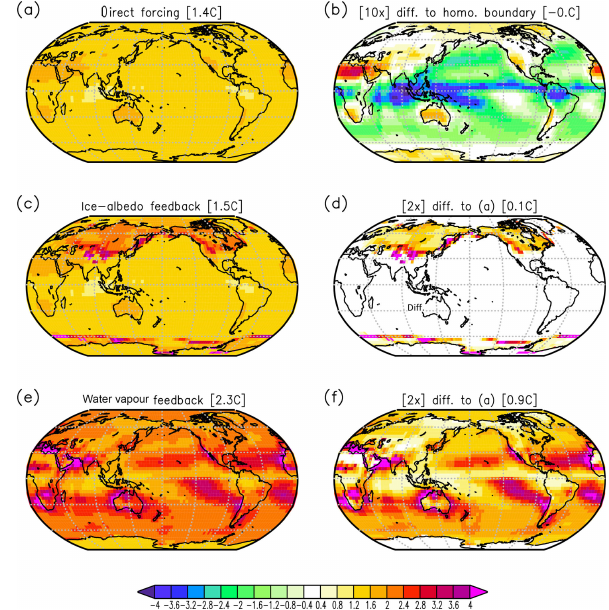
Figure 10. Local T surf response to doubling of the CO 2 concentra- tion in experiments without atmospheric transport (each point on the maps is independent of the others). (a) GREB with topography, humidity, cloud processes, and all other processes OFF. (b) Differ- ence of (a) to GREB with topography and all other processes OFF scaled by a factor of 10. (c) GREB model as in (a) , but with the ice–albedo process ON. (d) Difference of (c–a) scaled by a factor of 2. (e) GREB model as in (a) , but with hydrological cycle process ON. (f) Difference of (e–a) scaled by a factor of 2. For details on the experiments, see Sect.